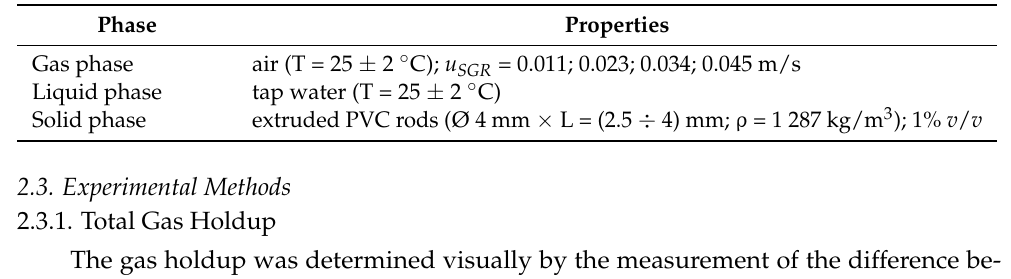
Table 6. Concentric jet-loop airlift bioreactor: Experimental